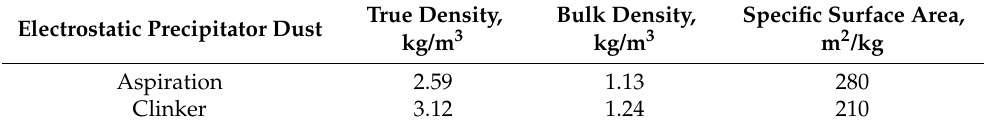
Table 1. Physical properties of the dusts. Electrostatic Precipitator Dust